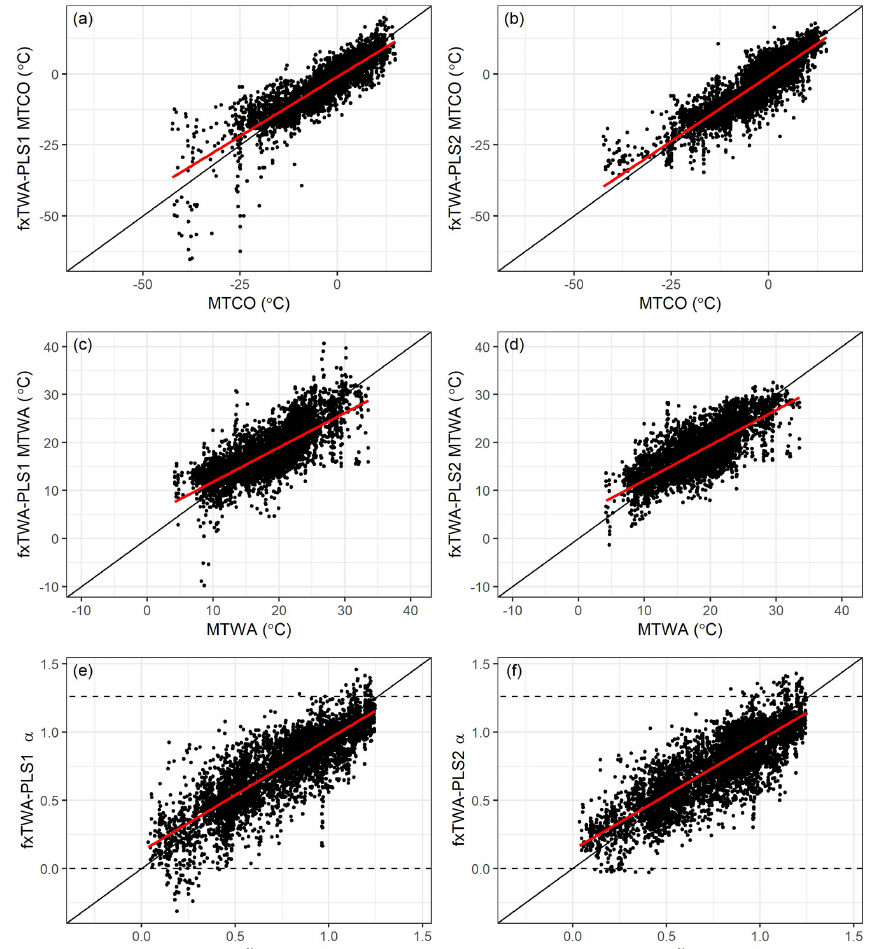
Figure A1. Training result using the last significant number of components for mean temperature of the coldest month (MTCO), mean temperature of the warmest month (MTWA) and plant-available moisture ( α ). The left column ( a , c and e ) shows the previous version (fxTWA-PLS1) and the right column ( b , d and f ) shows the modified version of fxTWA-PLS (fxTWA-PLS2). The 1 : 1 line is shown in black; the linear regression line is shown in red to show the degree of overall compression. The horizontal dashed lines indicate the natural limit of α